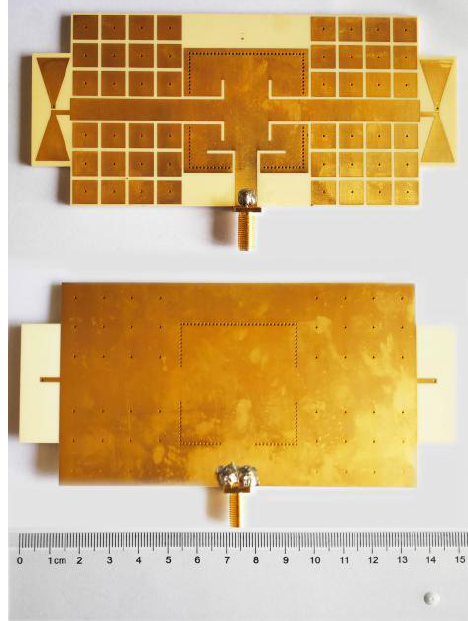
Figure 14. Photo of the fabricated array antenna.